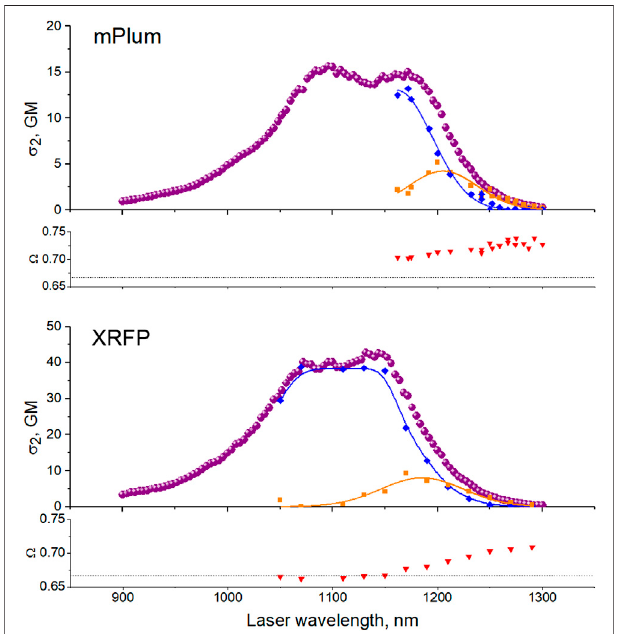
FIGURE 7 | Graphical solution of Eq. 16 (blue curves) and Eq. 21 (red FIGURE 6 | Resolution of two-photon transitions corresponding to two curve),to fi ndthe Δ μ x and Δ μ y componentsof Δ μ forDsRed2.Thestructureof differentconformationsofthechromophore ’ senvironmentinmPlum(top)and the DsRed2 chromophore is displayed in the background, illustrating the XRFP (bottom). Top panels: Purple circles represent the total effective 2PA molecular system of coordinates. Green dashed bi-directional arrows cross section σ 2 , total ( λ ) a , blue rhombs — contribution from the red from depict the direction of the oscillating transition dipole moment μ , calculated in ( ρ σ ( λ )) and orange squares – from the far-red form ( ρ σ ( λ )) . Bottom (List et al., 2012), for the chromophore in vacuum (light green) and in DsRed 2 , a 2 , b a b panels: Red triangles represent Ω values. The dashed line corresponds to the protein (dark green). The dotted light green arrow corresponds to a direction Ω (cid:2) 2/3 ( c (cid:2) 0) of μ calculated in vacuum in (Ansbacher et al. 2012). Purple dashed arrows correspond to the quantum mechanically calculated Δ μ vector in DsRed proteinenvironmentdescribed bythreedifferentmodels(Listetal.,2012);see text. The purple solid arrow is the selected Δ μ solution of Eqs 16,21 . It was selected based on the known Δ μ and μ vectors calculated in (List et al., 2012) and our MD simulations of the electric fi eld; see text. Green solid bi-directional arrows represent the two possible directions of the μ vector based on our measurement of c and the selected direction of Δ μ .